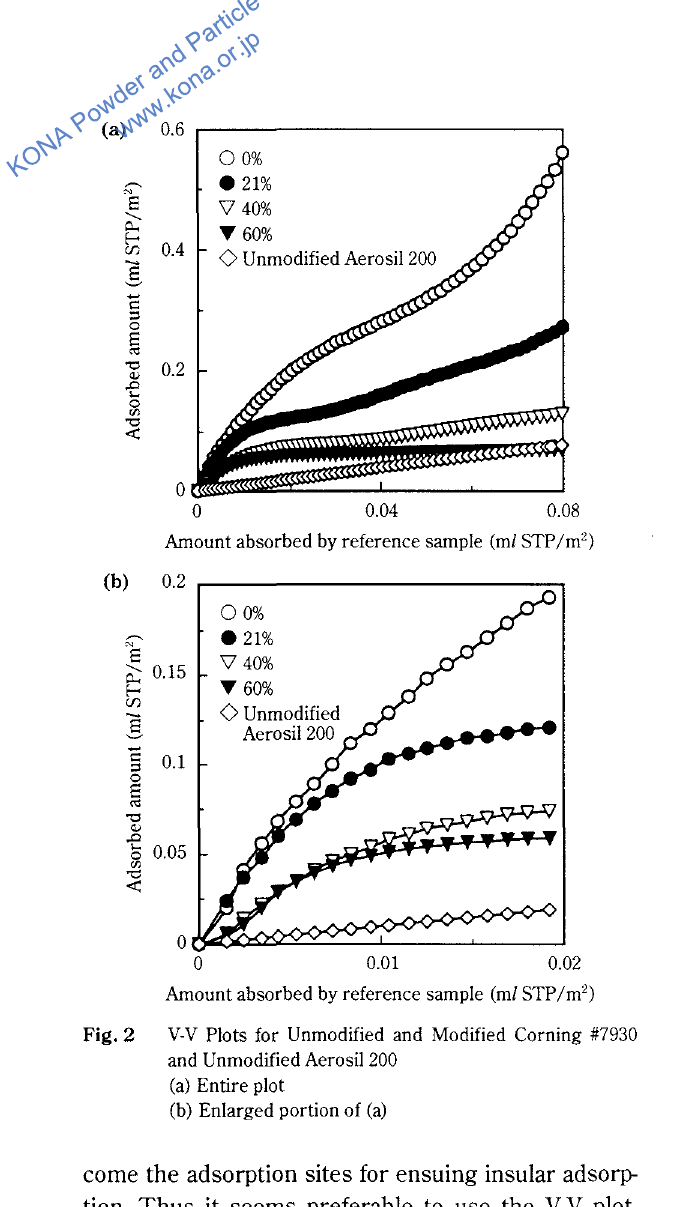
V-V Plots for Unmodified and Modified Corning #7930 and Unmodified Aerosil200 (a) Entire plot (b) Enlarged portion of